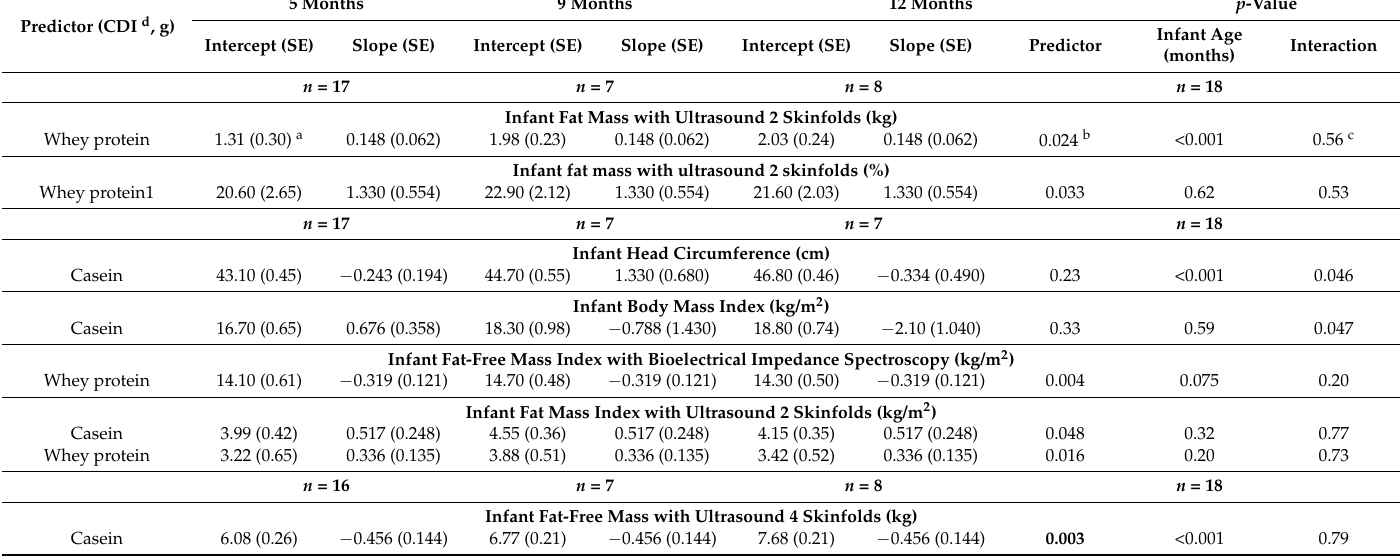
Table A3. Associations between calculated daily intakes of casein and whey protein and infant